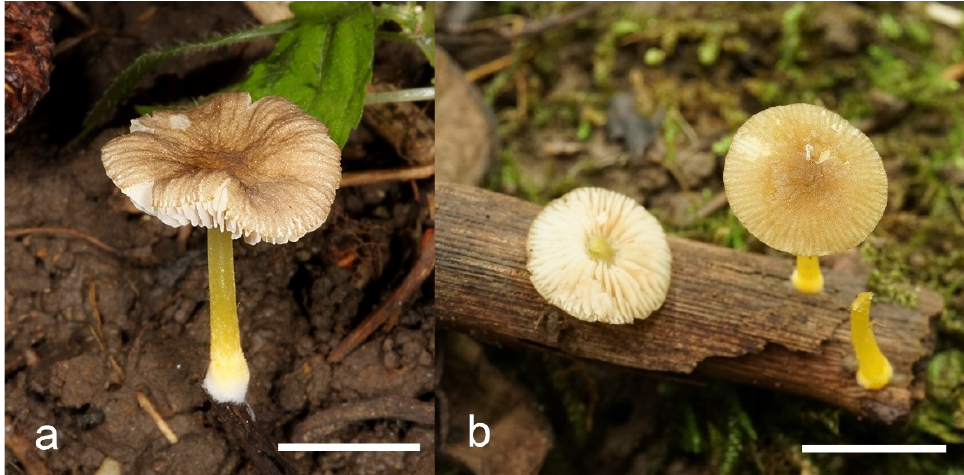
Figure 16. Pluteus parvicarpus basidiomata in situ: ( a ). LE 313357 (holotype), ( b ). LE 313631. Scale bars 1 cm.